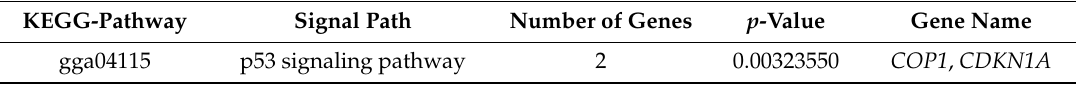
Table 11. The significantly enriched pathway for eight-week-old